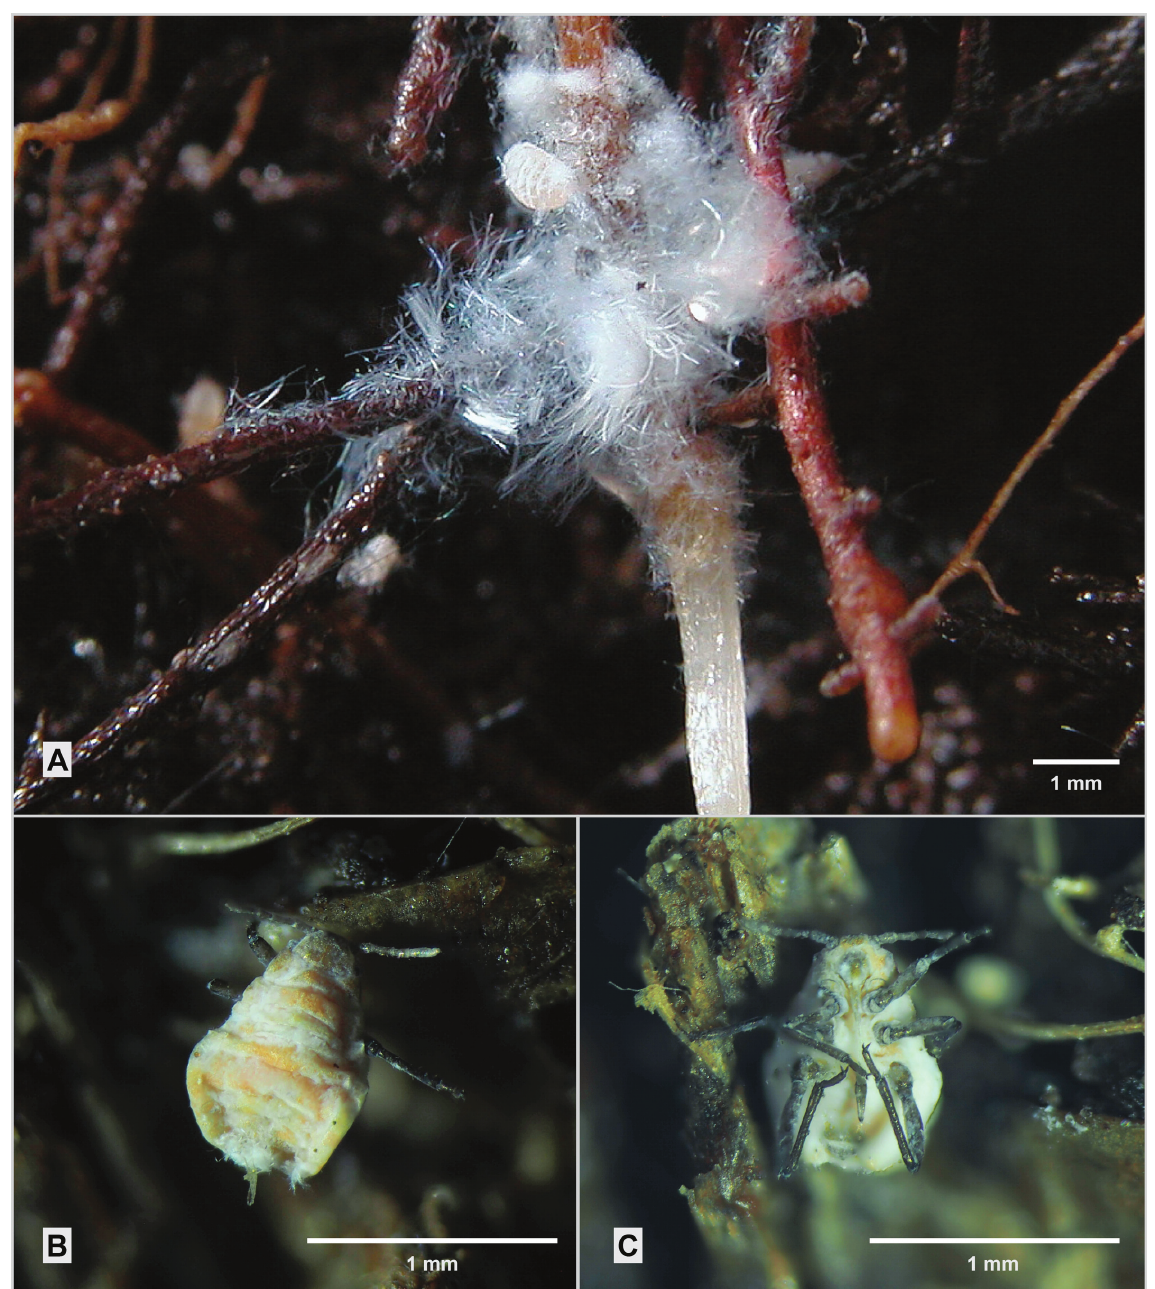
Fig. 22. Prociphilus pini (burmeister, 1835). A . Colony on thin Pinus sylvestris root in the moor layer of a pine forest on rock. B–C . Apt. from Polytrichum commune